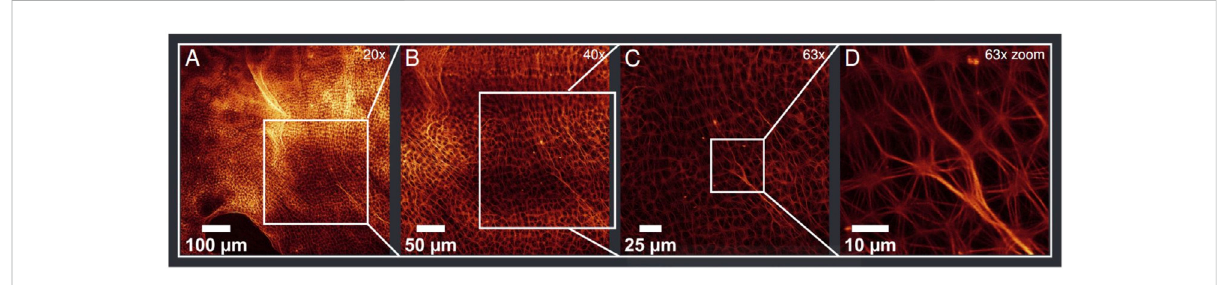
FIGURE 2 Thesameregionofasamplewithdifferentobjectivesandadditionalzoomin (D) .Magni fi cationsaregivenonthetoprightofeachimage (A – D) . (A) Shown is a large fi eld of actin asters with preform of asters displayed at top and bottom of the image (see Supplementary Material). (D) Shows characteristic bundling of MC